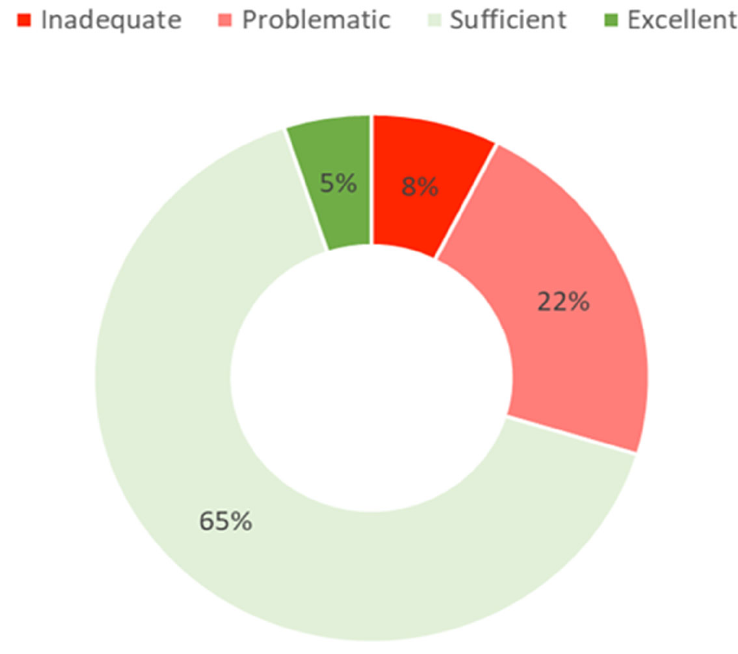
Figure 1. Distribution of the general health literacy levels of the Portuguese HLS 19 sample [7].